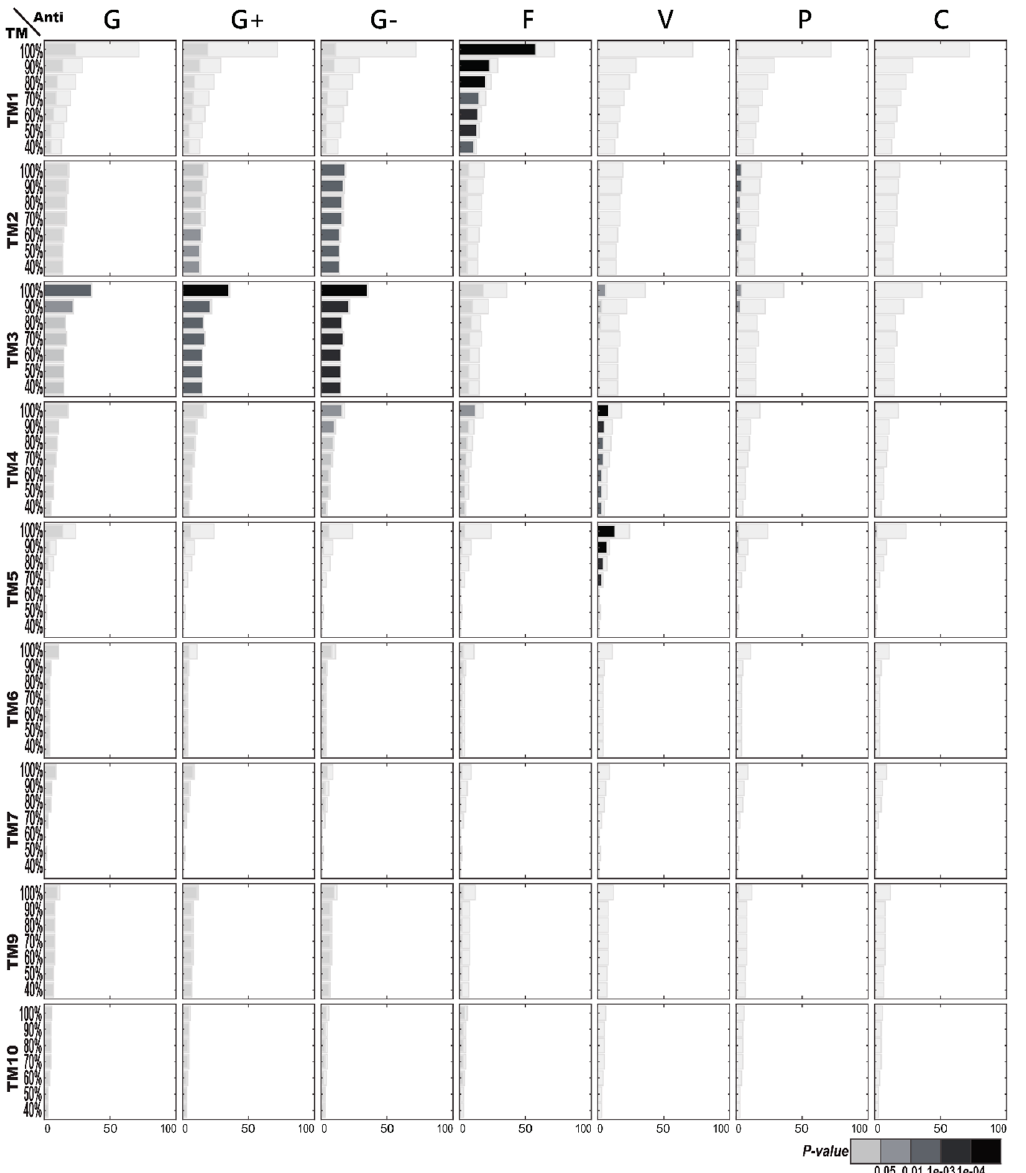
Figure 3. Antimicrobial peptide (AMP) functional enrichment analysis with respect to TM (template modeling) structures. The X -axis and Y -axis are, respectively, the number of AMP sequences and the percentage of sequence identity. The bar in light gray indicates the potential maximum number of AMP sequences with the specific function. TM8 was discarded because only the structural clusters which contain at least five AMPs are displayed here. Abbreviations: C, anticancer; F, antifungal; G, antibacterial; G+, anti-Gram+; G-, anti-Gram-; P, antiparasitic; V, antiviral.